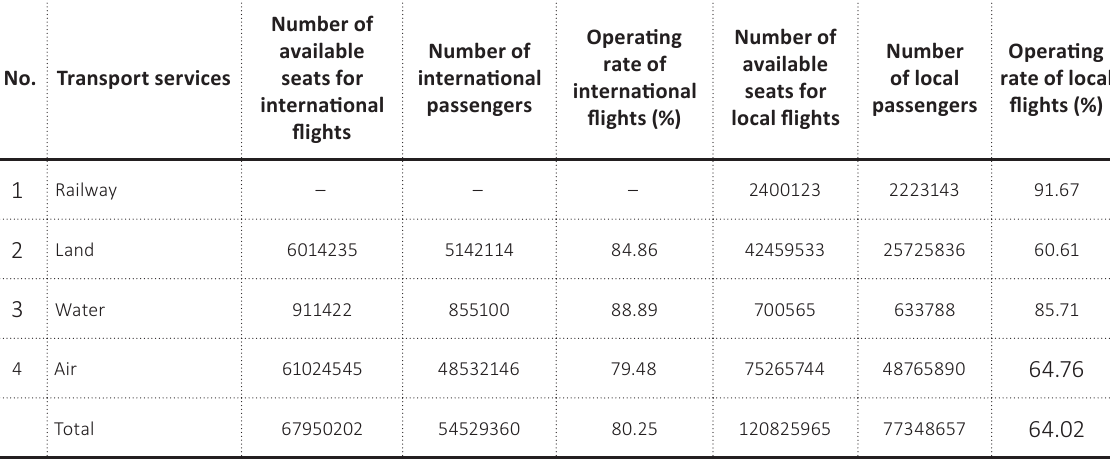
Table A4. Transport services in Saudi Arabia